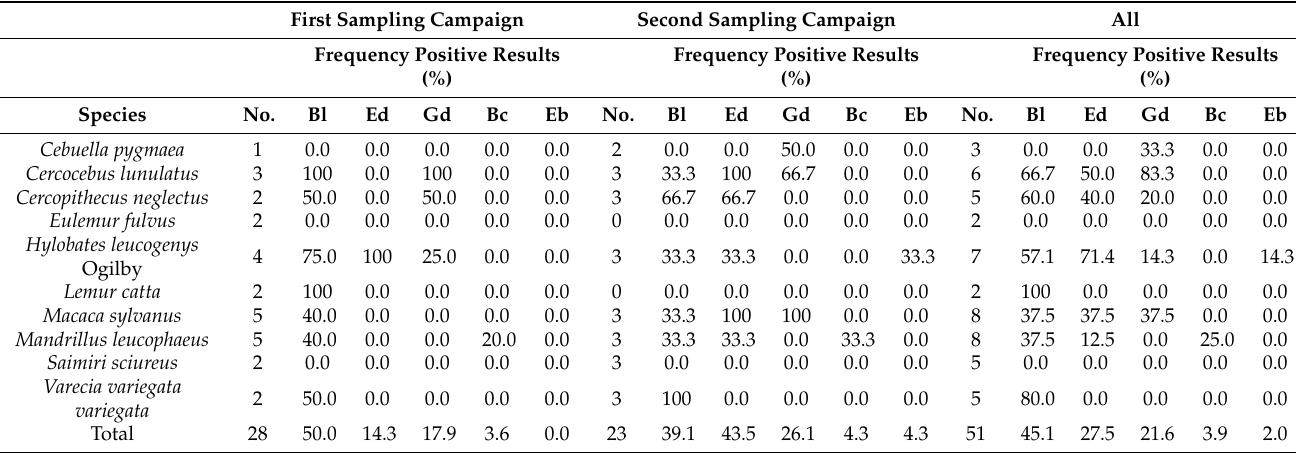
Table 1. Frequency of enteric protists detected at each sampling campaign in faecal samples from captive non-human primates in the C ó rdoba Zoo Conservation Centre (Spain).